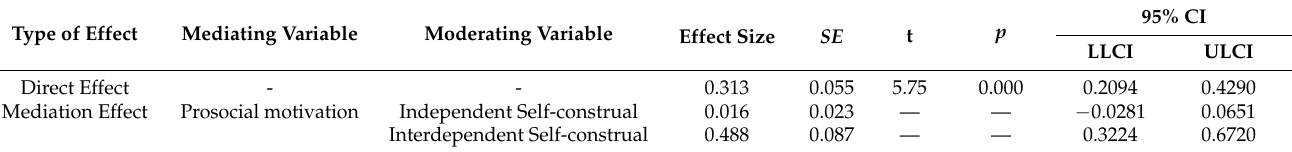
Table 1. Mediating role of prosocial motivation in moderating variables.